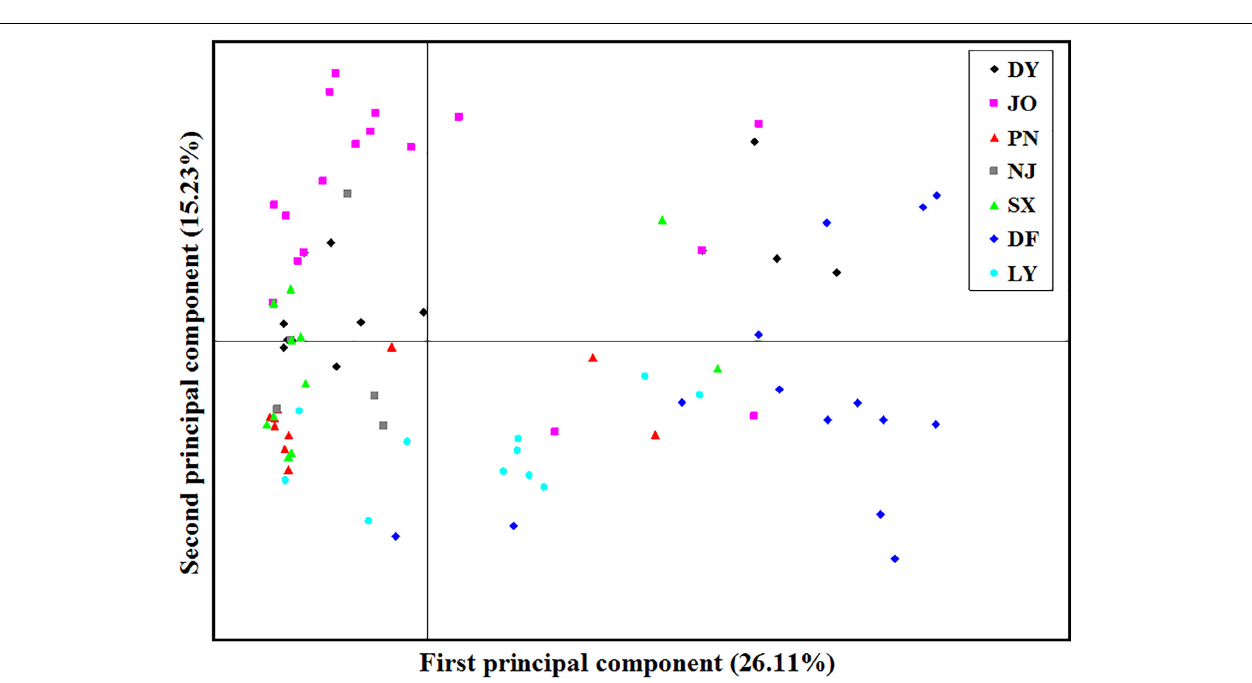
FIGURE 3 | Population structure-inferred membership parameter for 75 multi-locus haplotypes of Setosphaeria turcica populations in Fujian Province. Each haplotype is represented by a thin perpendicular bar and the length of each colored bar indicates the membership parameter for each cluster. Individual haplotypes are clustered on the basis of geographical origin (A,C) and mating type (B,D) , respectively. Sub-figures present the values of (cid:49) k and the optimal numbers of K = 2 clusters (A,B) , and the membership of each haplotype for the two clusters (C,D) . Thick black lines divide individual haplotypes into different sub-populations. DY, JO, PN, SX, LY, DF, and NJ represent S. turcica isolates collected from the Dongyou, Jian’ou, Pingnan, Songxi, Longyan, Dongfeng, and Nanjing of Fujian Province, respectively.